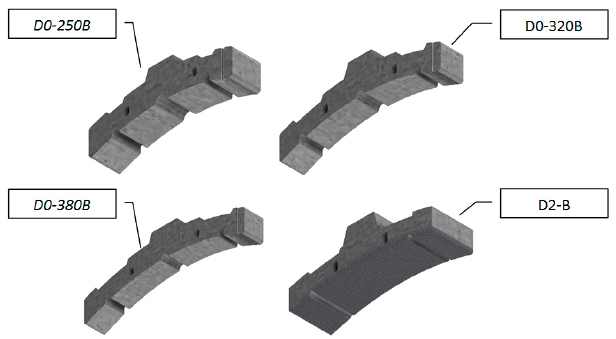
Figure 2. Exemplary castings made of phosphoric cast iron [23].